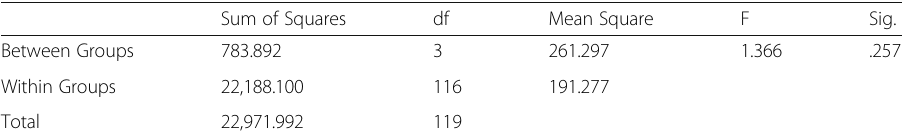
Table 4 One-Way ANOVA; Pretest of Level of Autonomy by Groups Sum of Squares df Mean Square Sig. Between Groups Within Groups